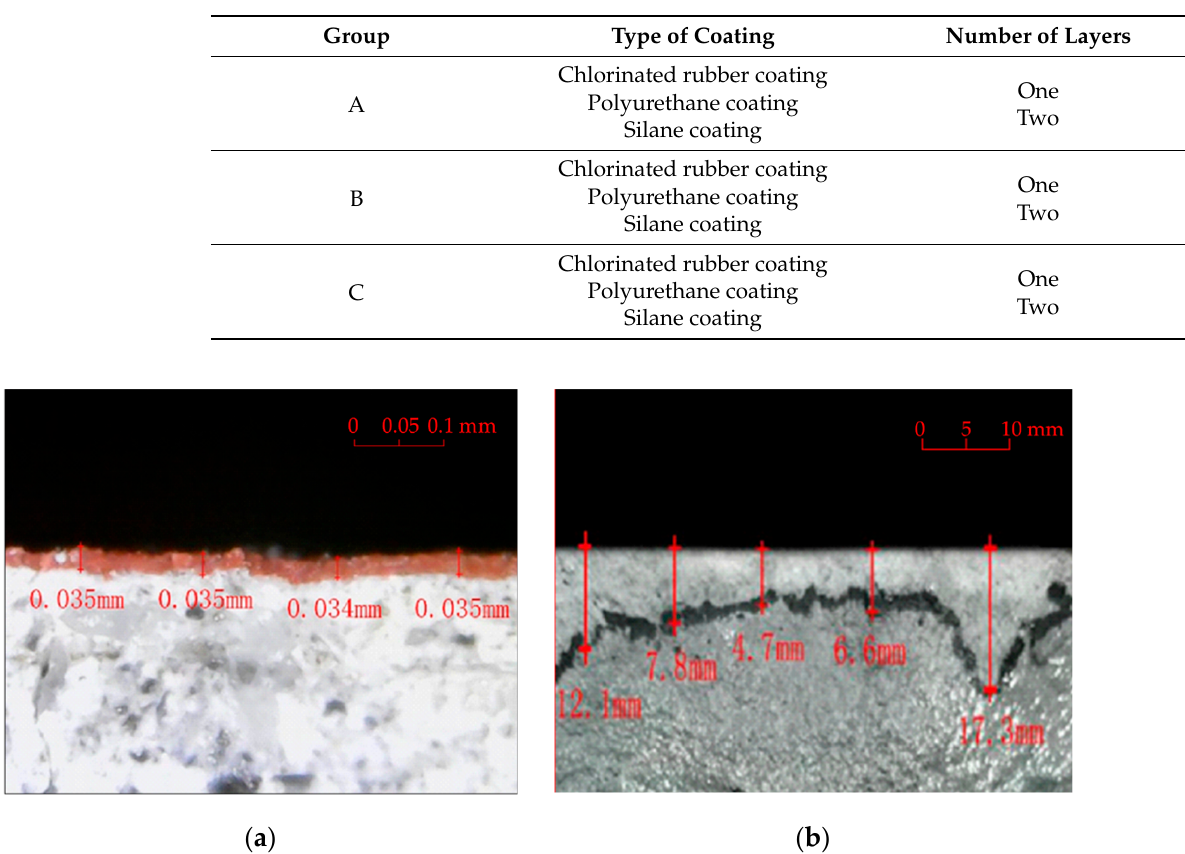
Table 5. Polymer coating types and layers used for the specimens.